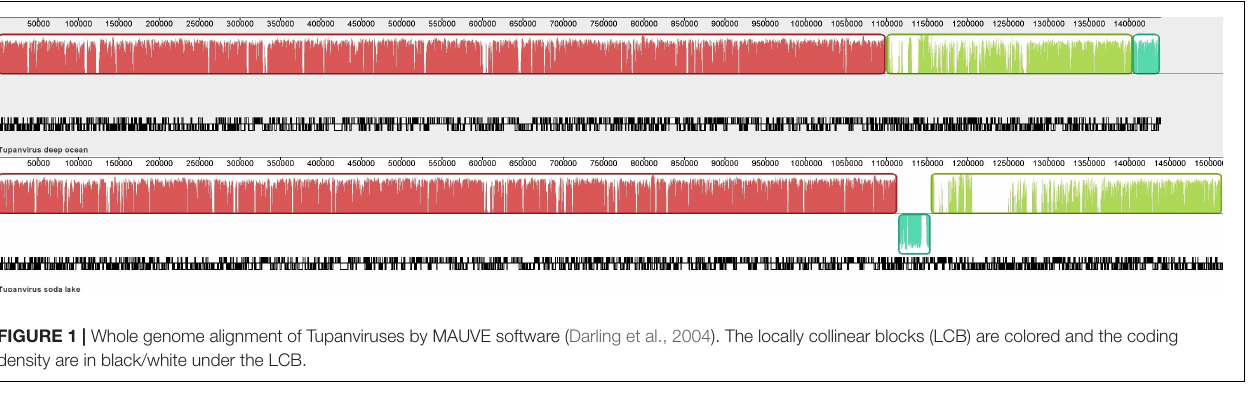
Frontiers in Microbiology |